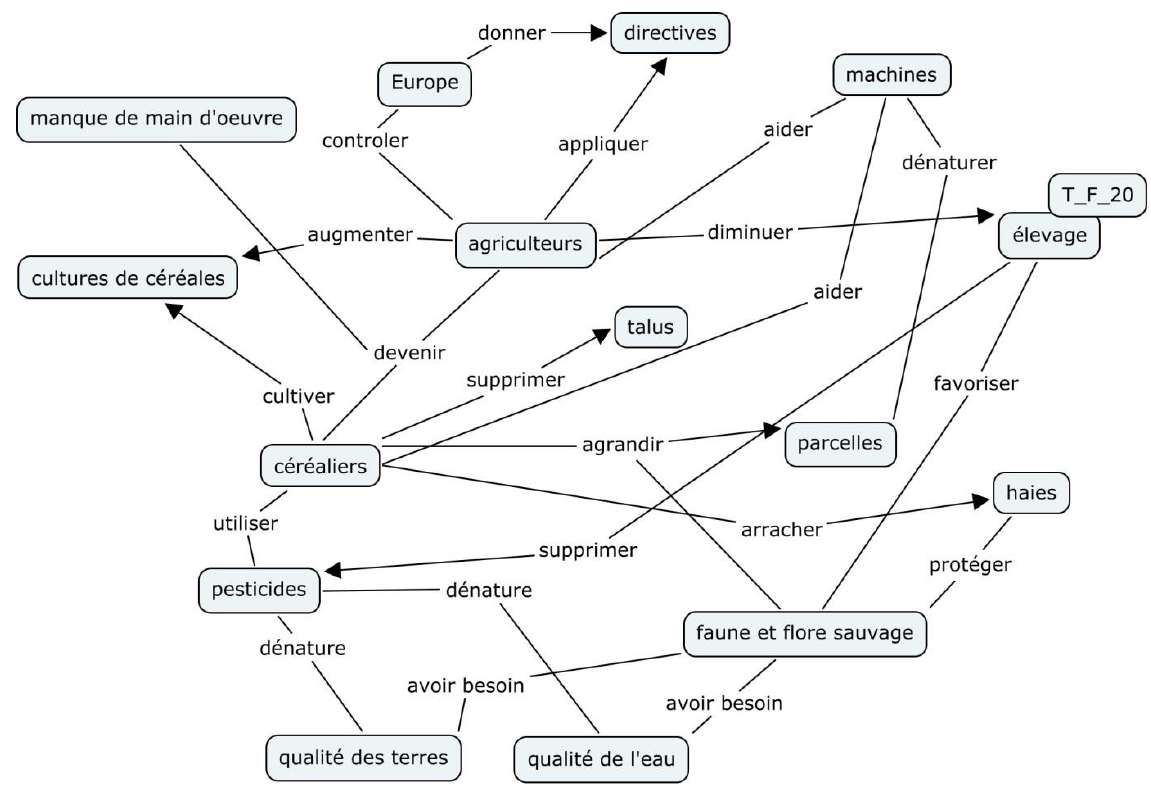
Figure A2.1 Example of an original